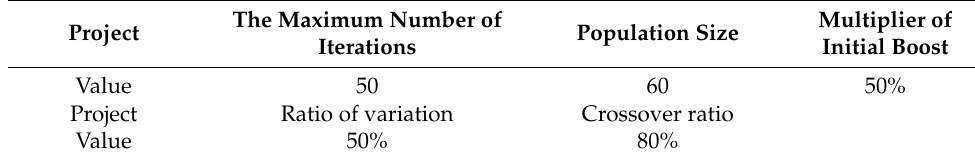
Table A3. Parameter setting of Table A3. Parameter setting of Octopus. Table A3. Parameter setting of Octopus. Table A3. Parameter setting of Octopus. Table A3. Parameter setting of Octopus.